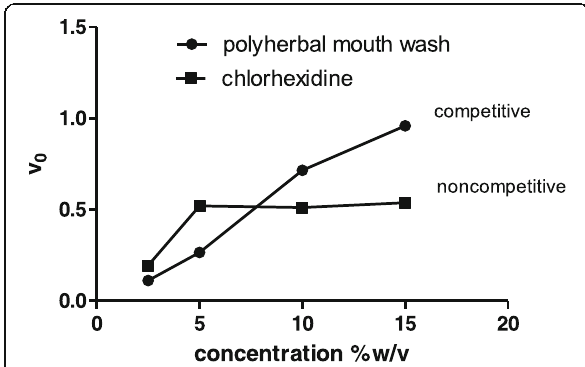
Fig. 7 Exponential response curves of Polyherbal mouth rinse and Chlorhexidine